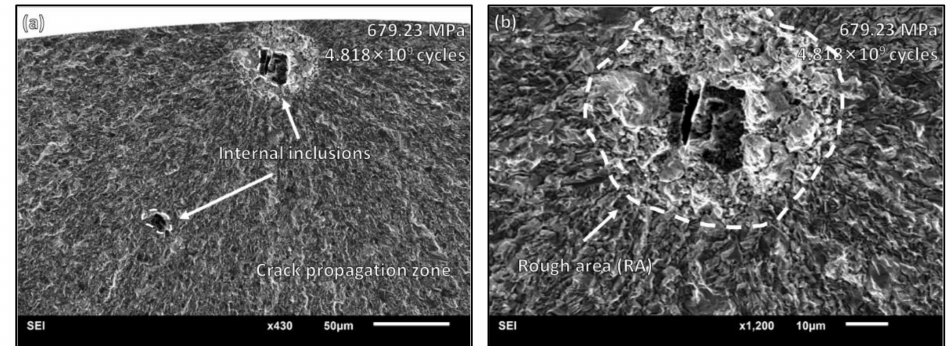
Figure 6. VHCF fracture morphology: ( a ) sub-surface inclusion distribution around the crack initiation site; ( b ) sub-surface rough area with relatively larger particle size and crack propagation zone outside the rough